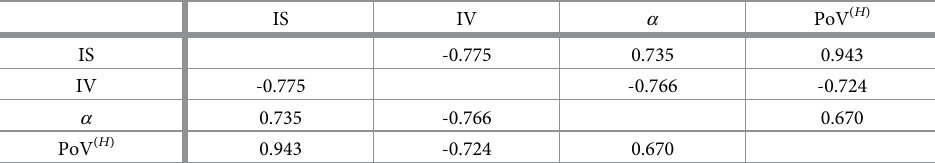
Table 1. Pearson’s correlation coefficients between pairs of statistical measures for all participants. IS